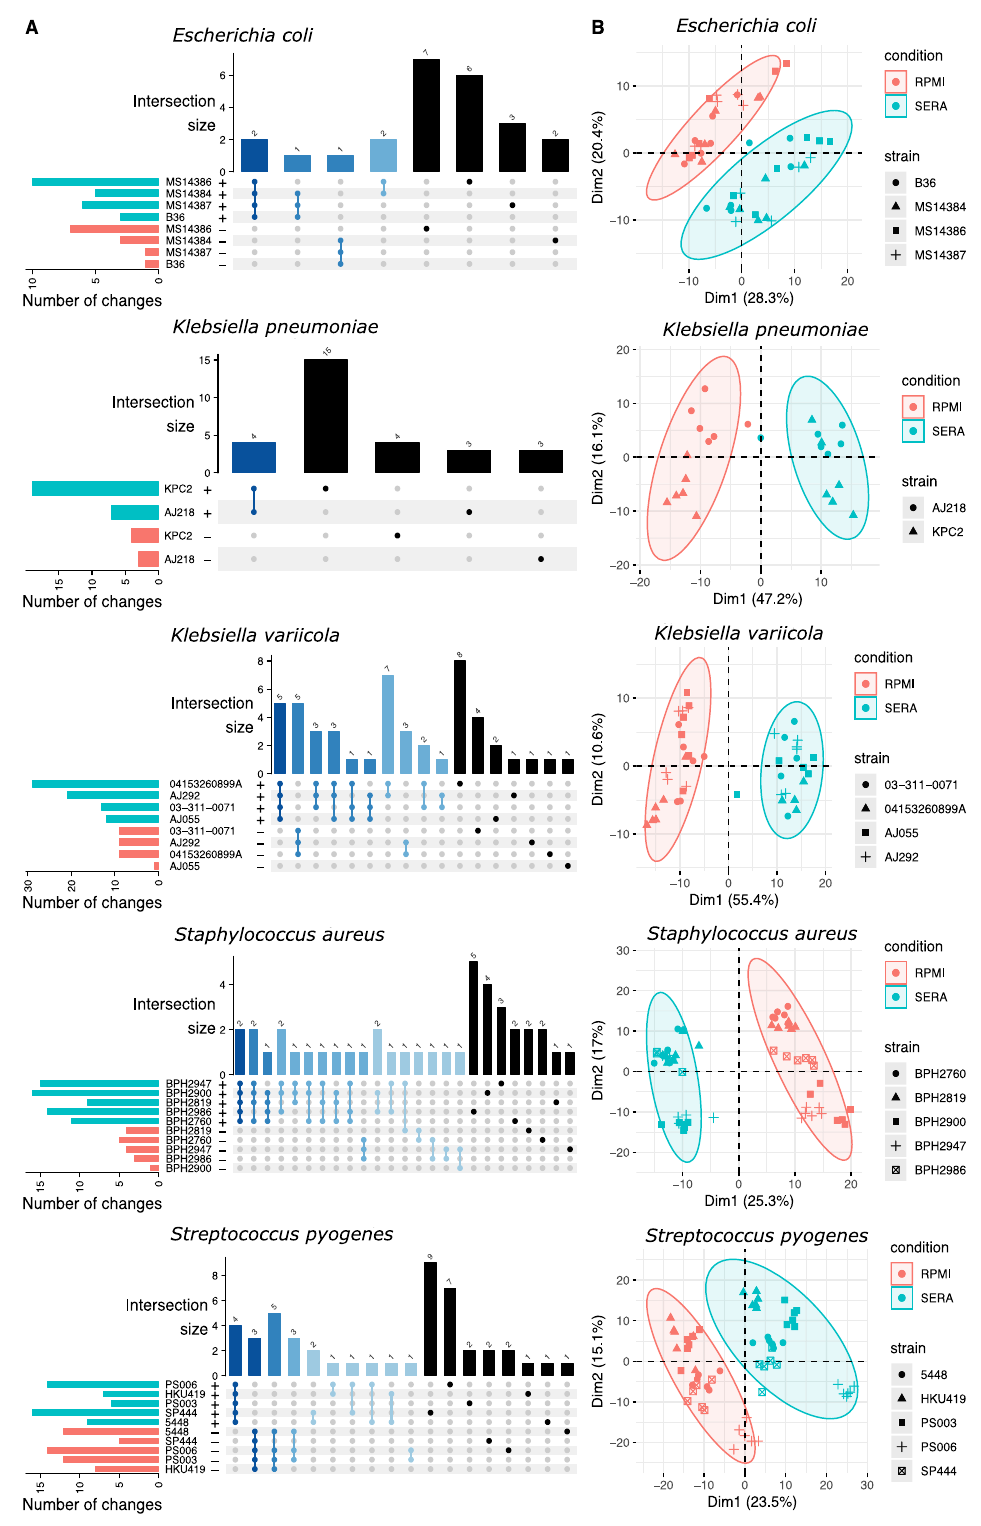
Fig. 6 | GC – MS analysis to assess the impact of serum exposure on the meta- bolome across the different species. A UpSet plot represents the shared and distinctive metabolome responses across strains of the same species. Only meta- bolites with signi fi cant differential abundance after exposure to human serum are